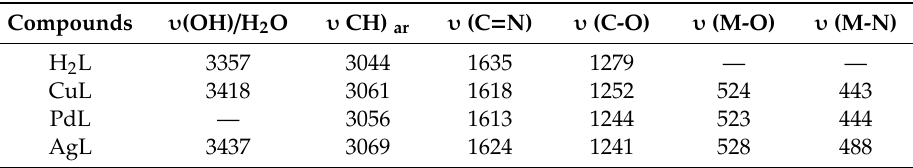
Table 1. The characteristic IR bands (cm − 1 ) of the synthesized compounds.